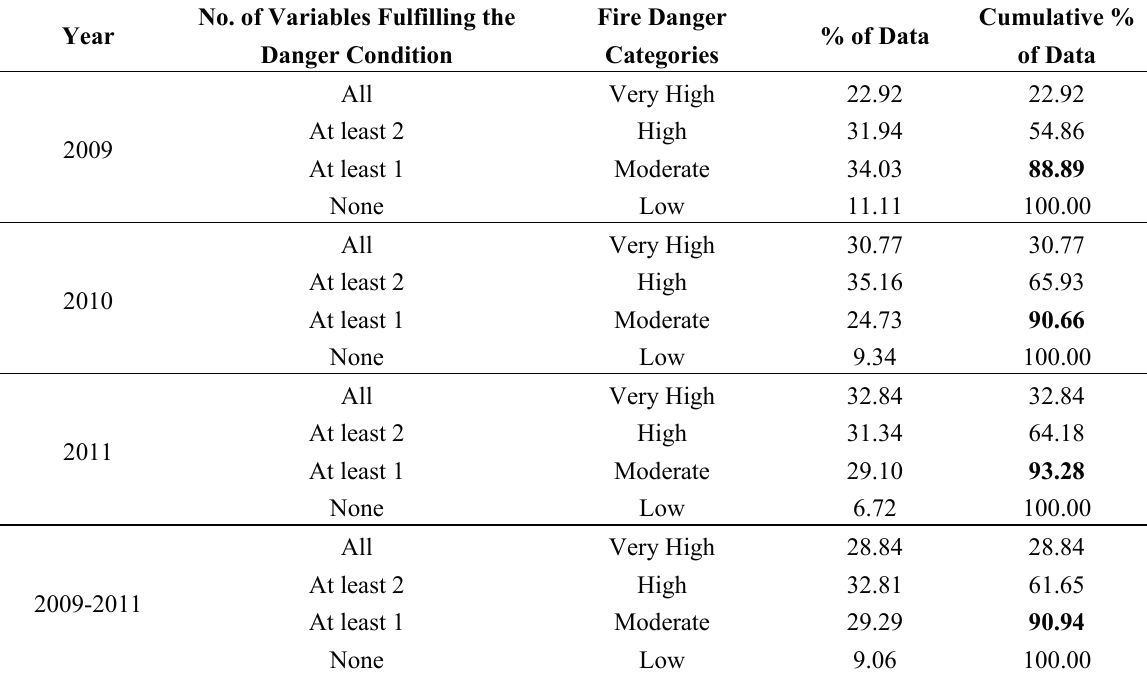
Table 2. Percentage of data under each fire danger category using the combined variable of T S , NMDI, and NDVI in comparison with the fire